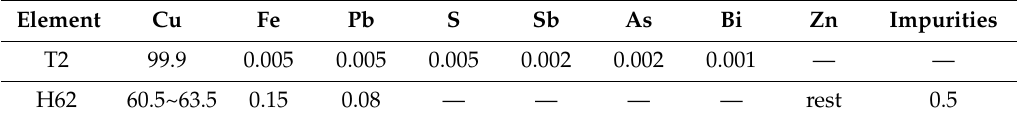
Table 1. Chemical composition of the base materials. (mass fraction / %).